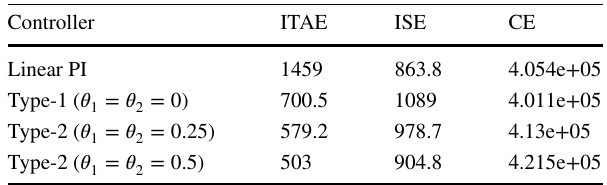
Table 7 Performance indices for tracking response